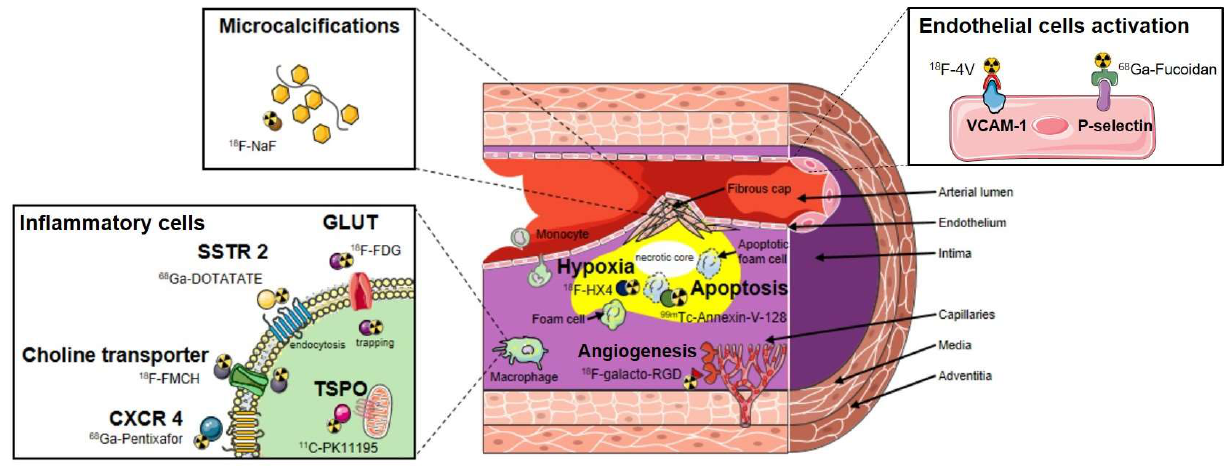
Figure 1. Vascular targets and corresponding examples of nuclear probes for the molecular imaging of atherosclerosis.